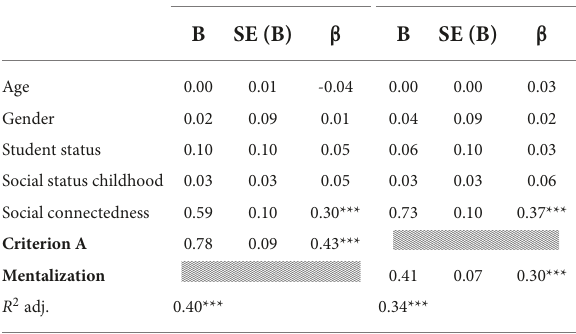
TABLE 3 Associations with